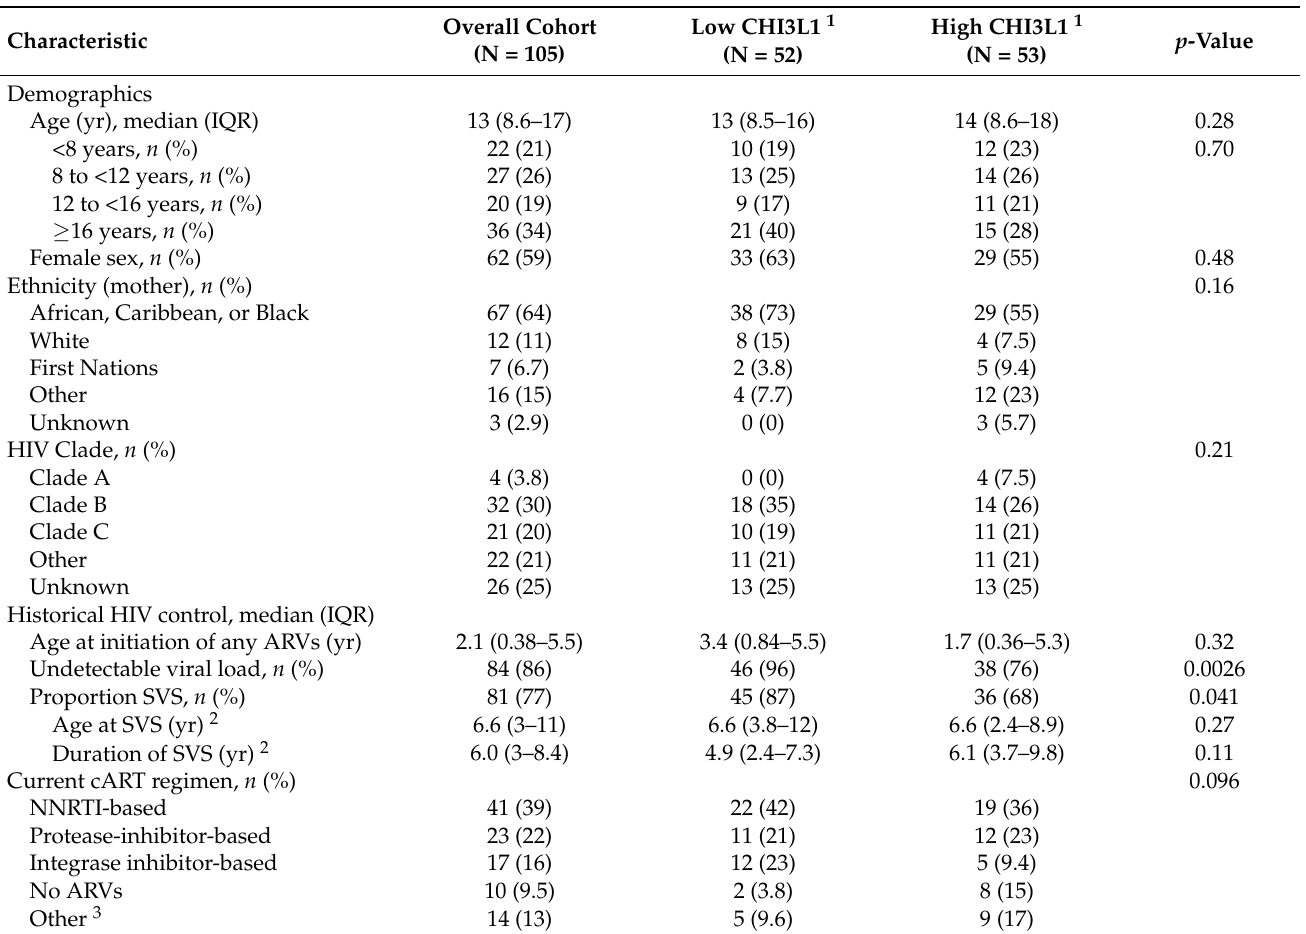
Table 1. Characteristics of 105 children living with HIV, according to plasma chitinase-3-like-1 (CHI3L1) protein